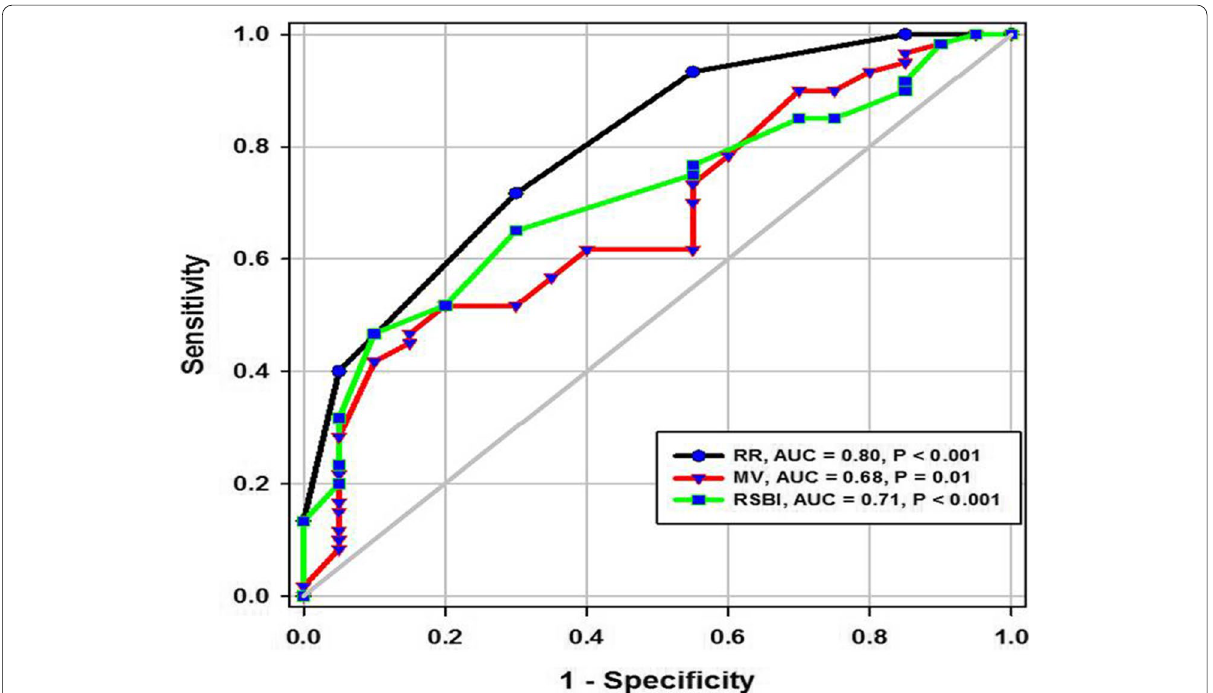
Fig. 5 ROC curve of RR, MV, and RSBI in the prediction of successful weaning